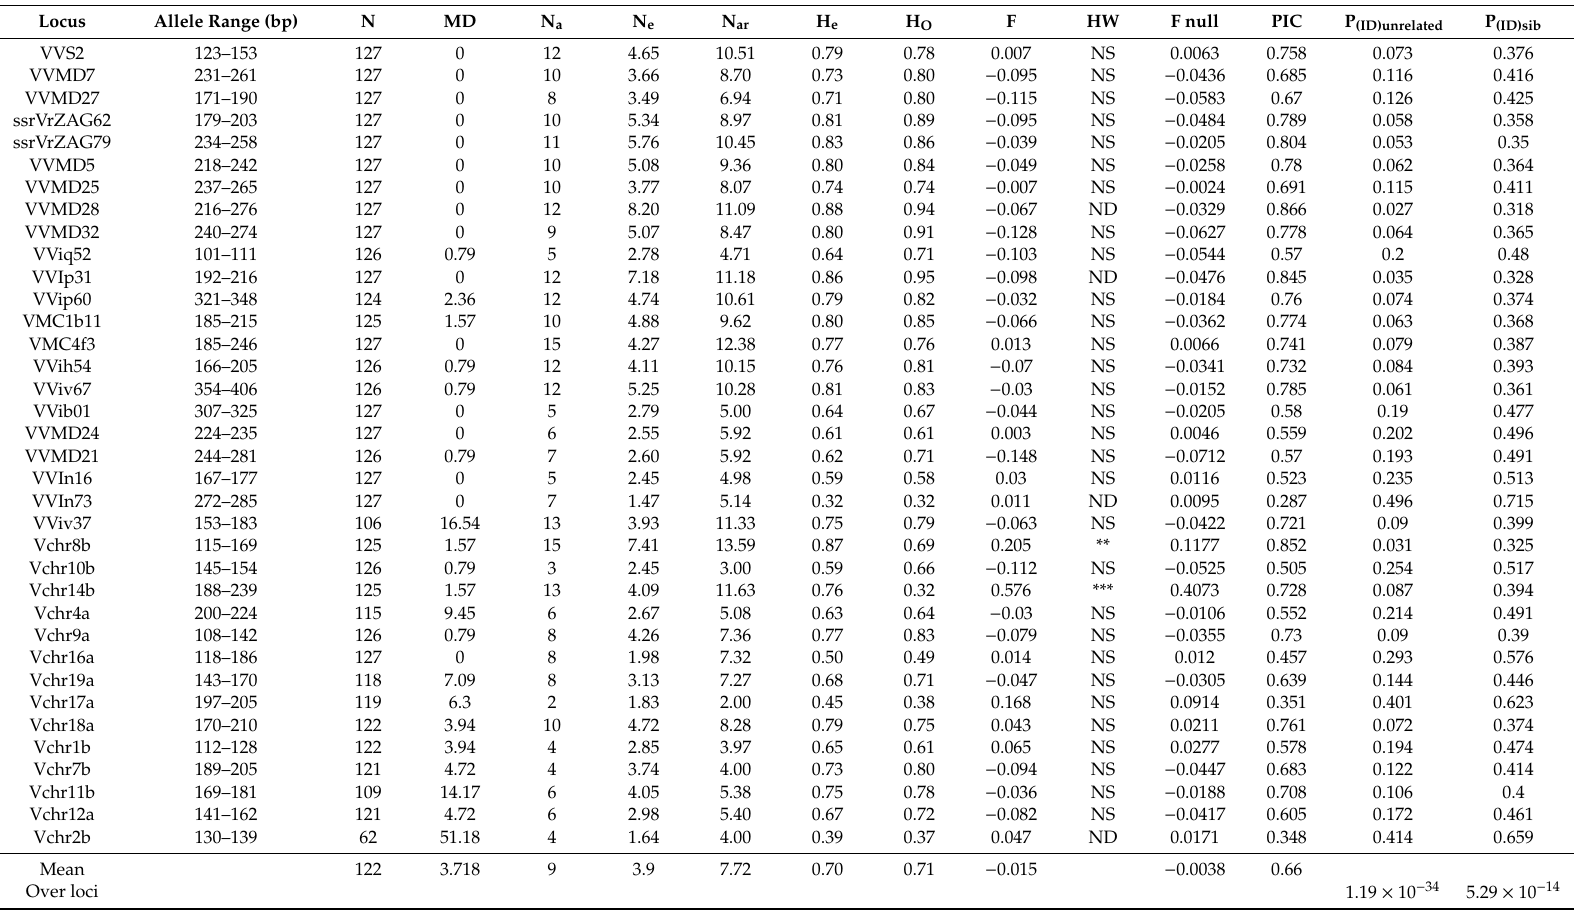
Table 2. Genetic diversity parameters assessed for 36 SSR